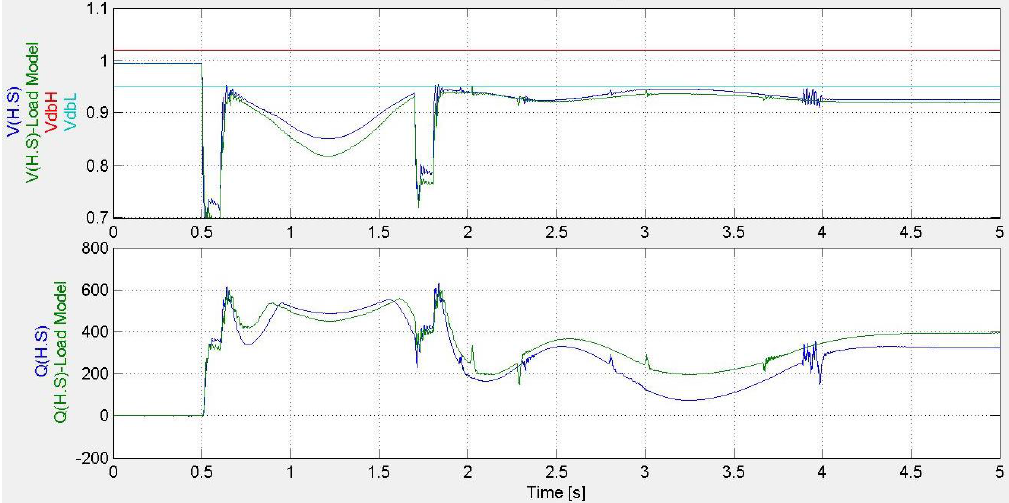
Figure 13. A 765 kV line fault nearby Shin-Jecheon bus considering induction motor and ZIP load model; Shin-Jecheon bus voltage (first row) and reactive power of SVC (second row); RTHS (blue line) and large-scale RTS (green line).